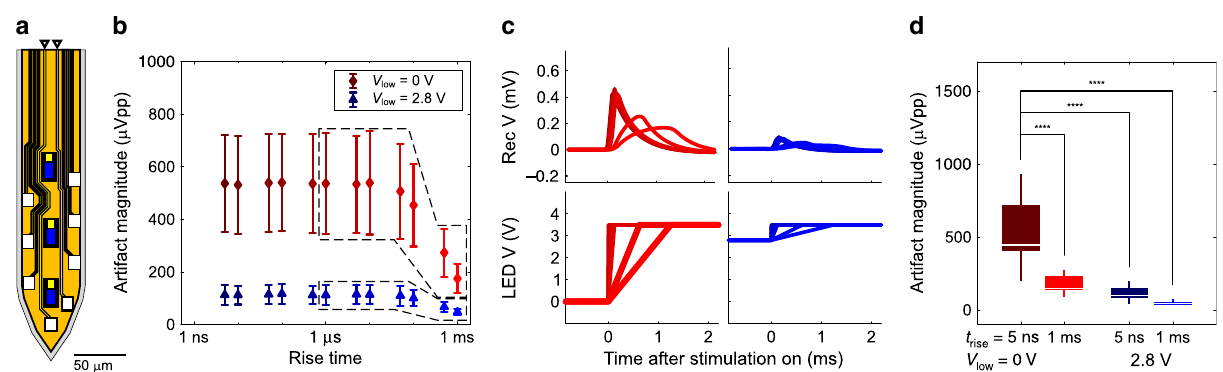
Fig. 5 Effect of transient pulse shaping on residual artifact. a Schematic illustration of the tip of a miniSTAR μ LED optoelectrode. Locations of the electrodes and the interconnects from which the signals were recorded are indicated with rectangles with bold black lines and black arrowheads, respectively. b Mean peak-to-peak magnitude of highpass fi ltered stimulation artifact recorded from the channels indicated in part a for two different low- level voltages ( V low = 0 V and V low = 2.8 V). A high-level voltage of 3.5 V was used. x coordinates indicate the 10 – 90% rise time of the pulse, symbols (circle and triangle) indicate the mean, and error bars indicate one standard deviation ( n = 35). c Mean waveforms of recorded stimulation artifact, whose mean peak-to-peak magnitudes are shown inside the polygon with dashed lines in part b , and their input voltage signals. Stimulation artifact resulting from an input voltage signal is indicated with the same color. d Peak-to-peak magnitudes of highpass fi ltered stimulation artifact for a few selected conditions whose means are shown in part b . Boxes indicate interquartile ranges, white lines medians, and whiskers extreme values. Mean (±SD) peak-to-peak magnitudes are 535.80 (±182.94), 173.99 (±55.76), 111.92 (±39.55), and 46.53 (±11.33), from left to right. A detailed description of the samples, statistical tests used, and the results of statistical tests are provided in Supplementary Table